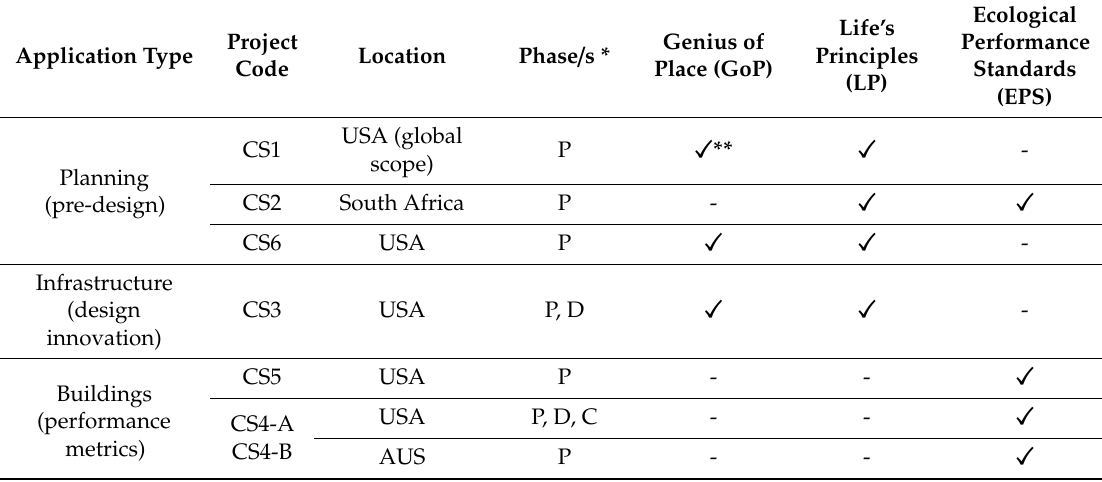
Table 2. Summary of case-study projects and their